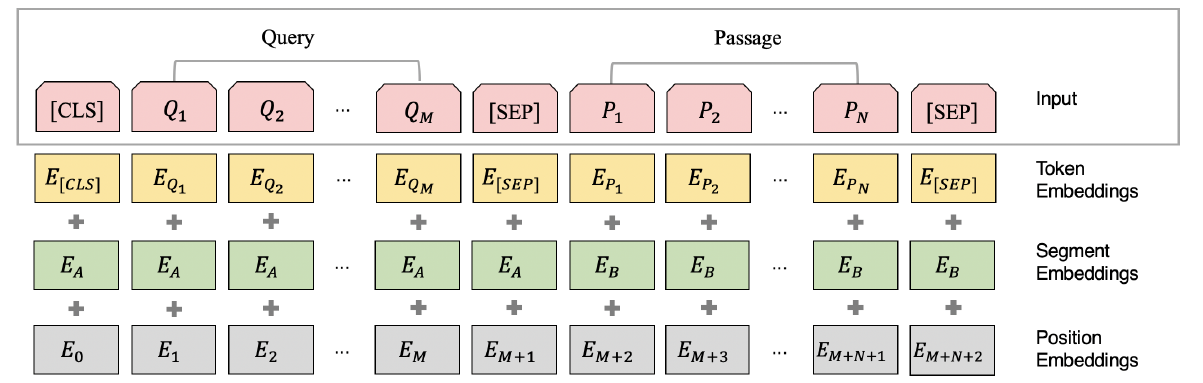
Figure 4. BERT input representation.